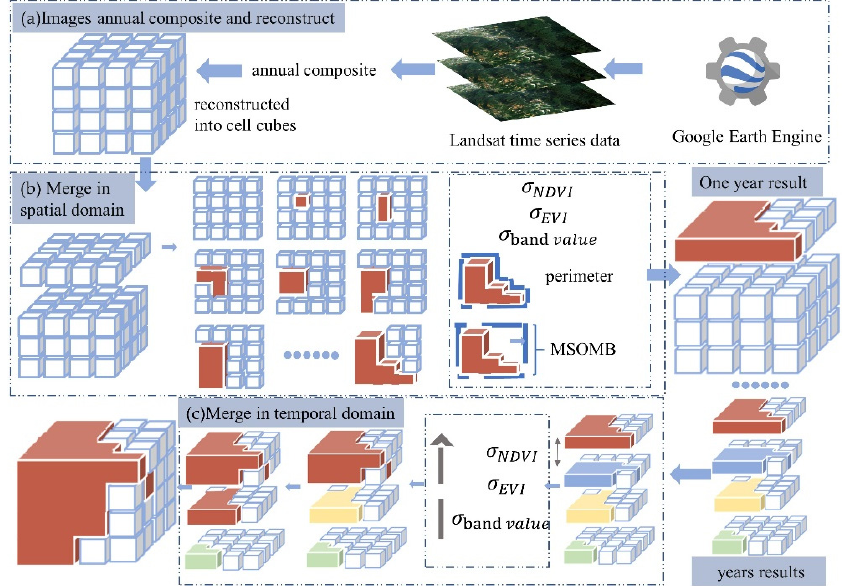
Figure 3. Methodological flowchart for the ( a ) annual composite and reconstruct and ( b ) merging the IST-cube in the spatial domain. MSOMB = minimum possible side length of the minimum bounding box. ( c ) Merging the IST-cube in the temporal domain.